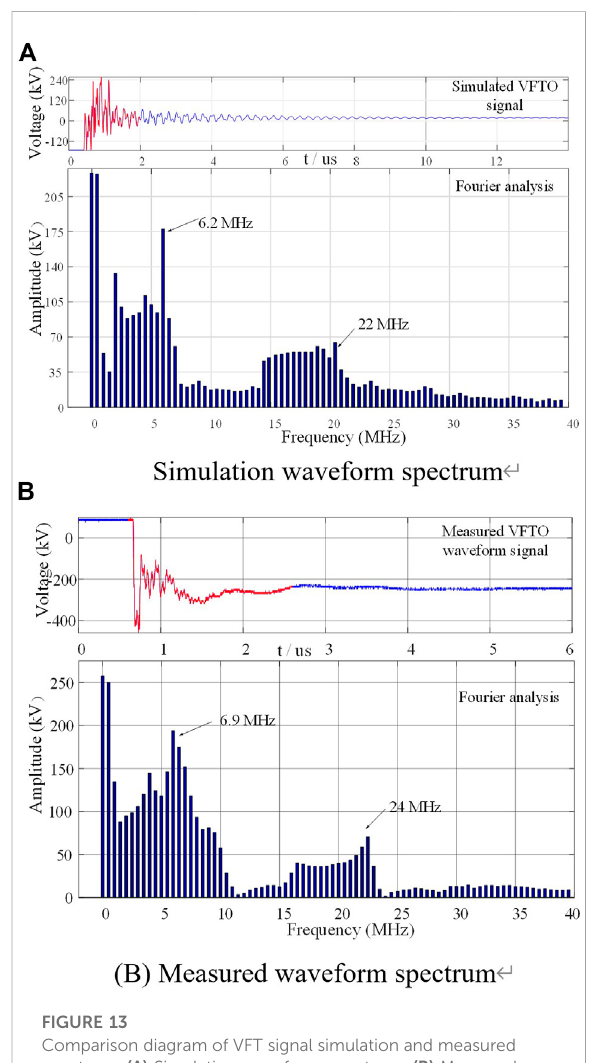
FIGURE 13 Comparison diagram of VFT signal simulation and measured spectrum. (A) Simulation waveform spectrum. (B) Measured waveform